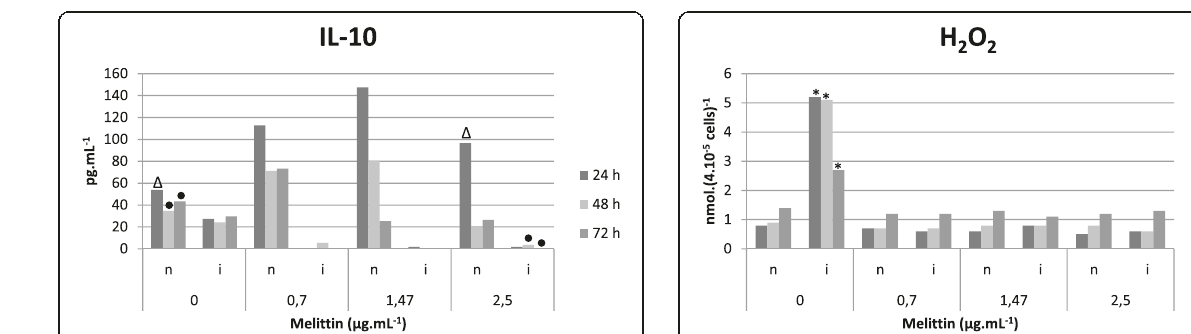
Fig. 6 Determination of H 2 O 2 levels in the supernatant of uninfected macrophages ( n ) and infected macrophages ( i ) after melittin treatment (0, 0.7, 1.47 and 2.5 μ g.mL − 1 ) at 24, 48 and 72 h. Data is presented as mean of three independent measurements.* p < 0.05 for infected cells versus non-infected cells (24, 48 and 72 h) without melittin addition. All treated infected cells (24, 48 and 72 h; 0, 0.7, 1.47 and 2.5 μ g.mL − 1 ) were statistically different ( p < 0.05) of the corresponding non-treated